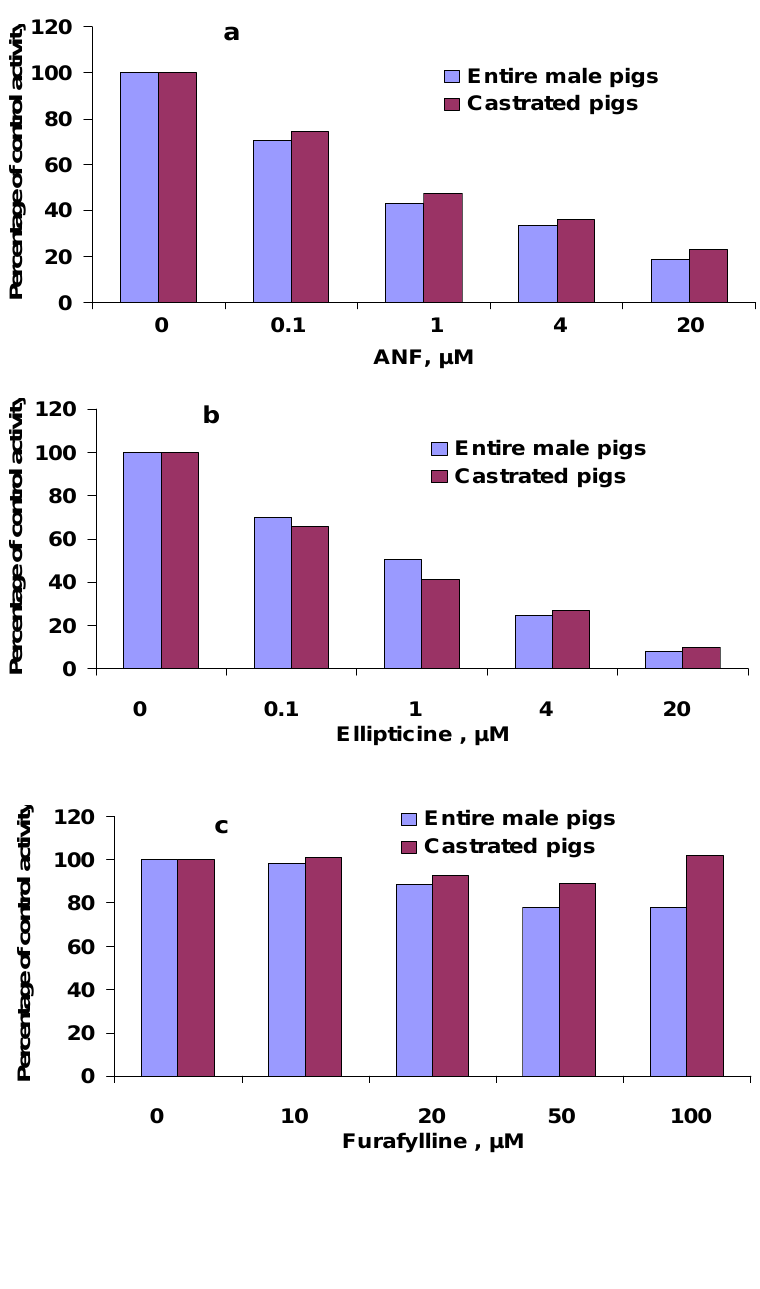
indicate the involvement of a single enzyme; involvement of several enzymes with similar K would also result in a monophasic Eadie-Hofstee plot. Figure 4. Inhibition of 7-ethoxyresorufin O -deethylation (EROD) in hepatic microsomes from castrated and entire male pigs by ANF (a), ellipticine (b) and furafylline (c). Assays were performed as described in the Experimental section. Values are expressed as percentages of activities in control incubations and are the mean of duplicates (differences between the duplicates were below